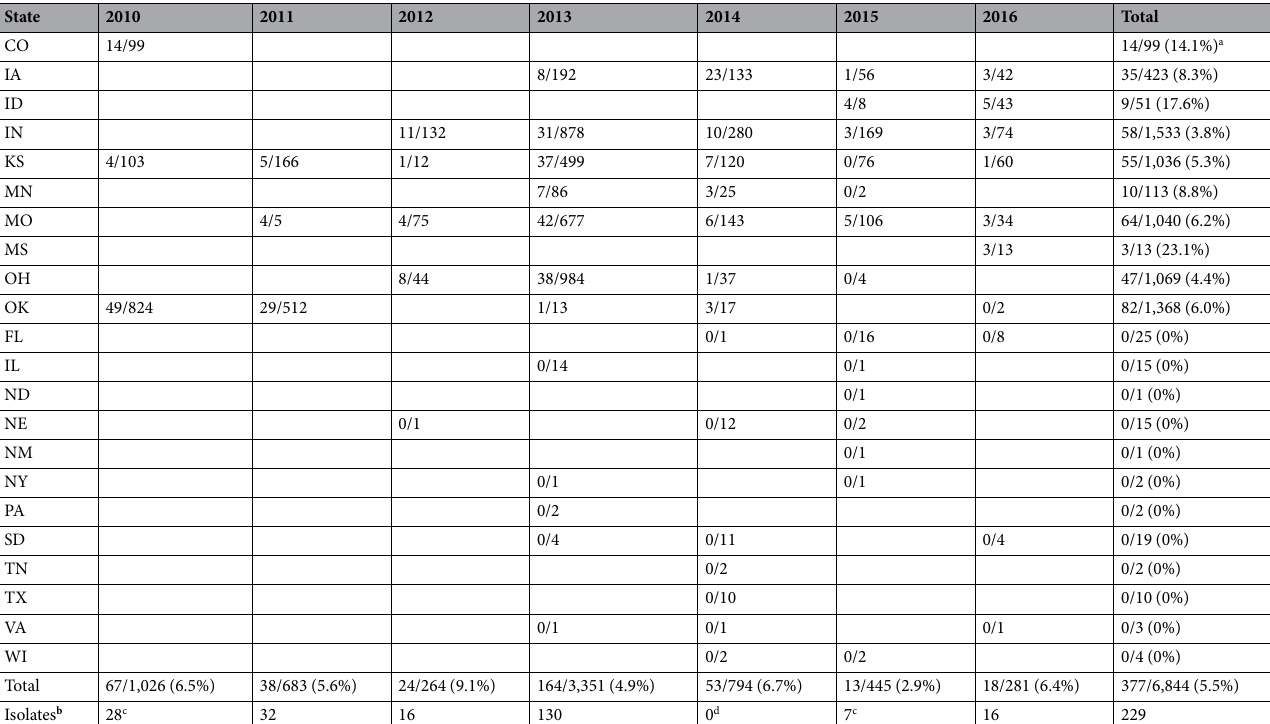
Table 1. Prevalence of Brucella canis in canine populations collected from 22 states of the US. a Positive/total (positive rate%). b Number of B . canis isolates obtained from positive samples. c Not all positive samples were subjected to bacterial isolation for 2010 and 2015. d No sample was subjected to bacterial isolation for year